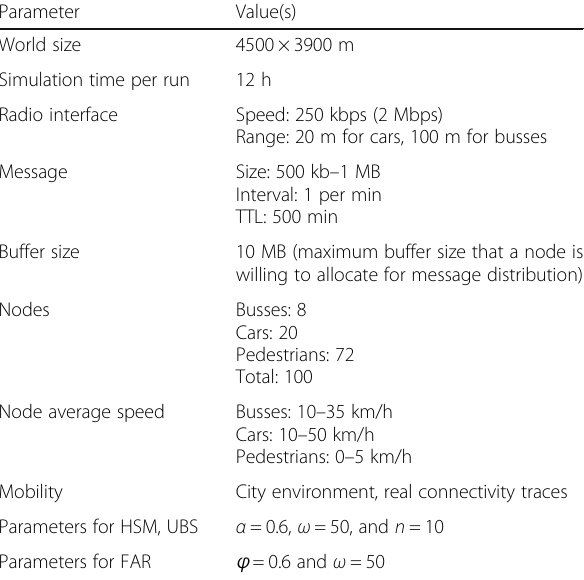
Table 3 Parameters used in simulations